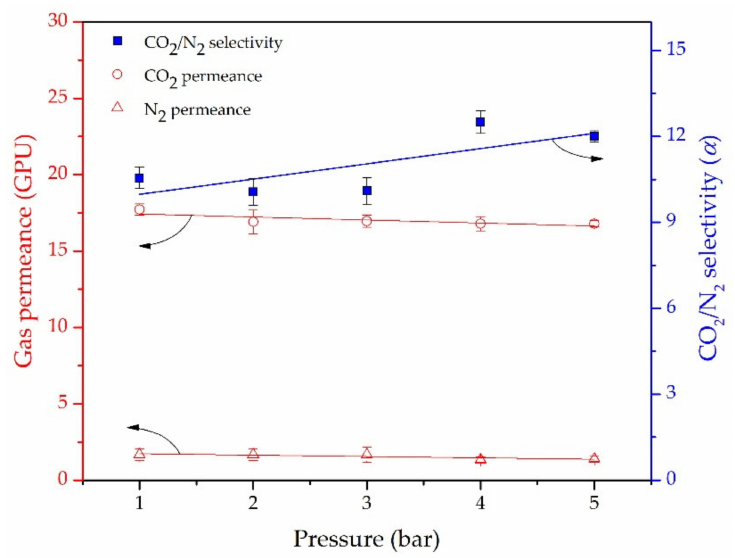
Figure 8. Effect of feed pressure on the gas permeance and ideal selectivity of CO 2 /N 2 at 25 ◦ C for the P15 membrane.